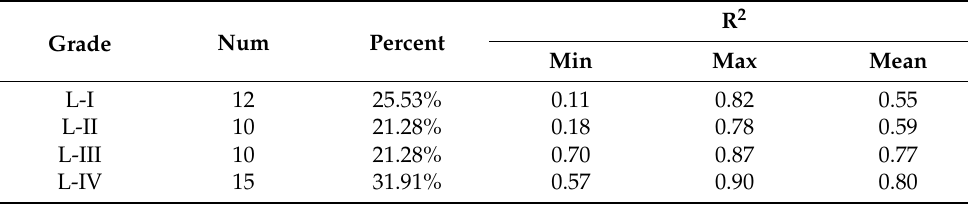
Figure 18. Distribution of feature points. Table 3. Relationship between landslide grade and correlation coefficient.